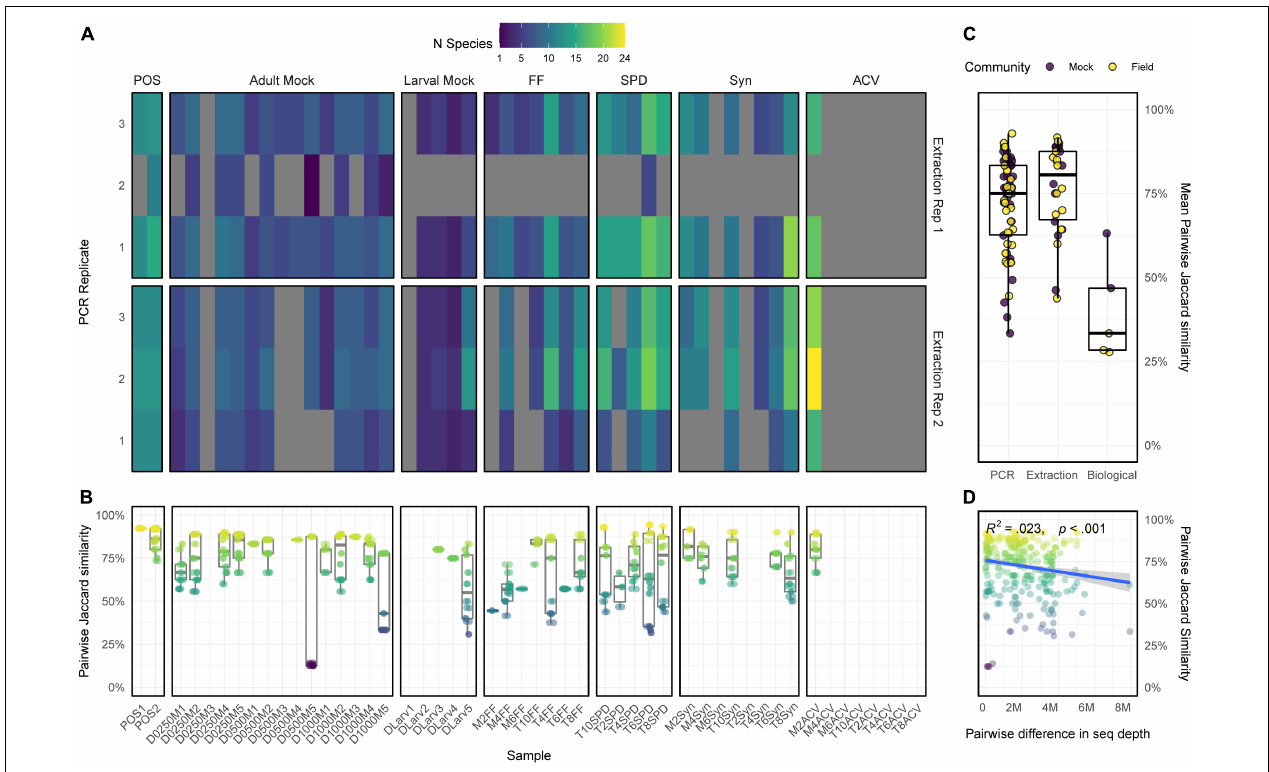
FIGURE 2 | (A) Total number of species observed within each replicated sample prior to application of detection threshold, with complete replicate dropouts indicated in gray. (B) Pairwise Jaccard similarity (presence/absence) coefficients between all replicates from each sample (C) mean Jaccard coefficient between PCR replicates of the same DNA extract, DNA extraction replicates of the same sample, and separate samples obtained using the same collection method (biological replicates). (D) Relationship between pairwise Jaccard similarity and sequencing depth difference for all